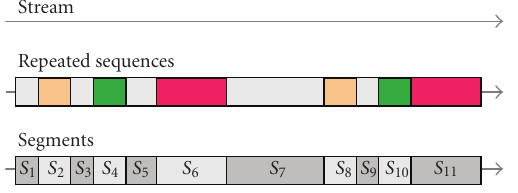
Figure 7: Stream segmentation using detected repeated sequences. Eleven segments generated.